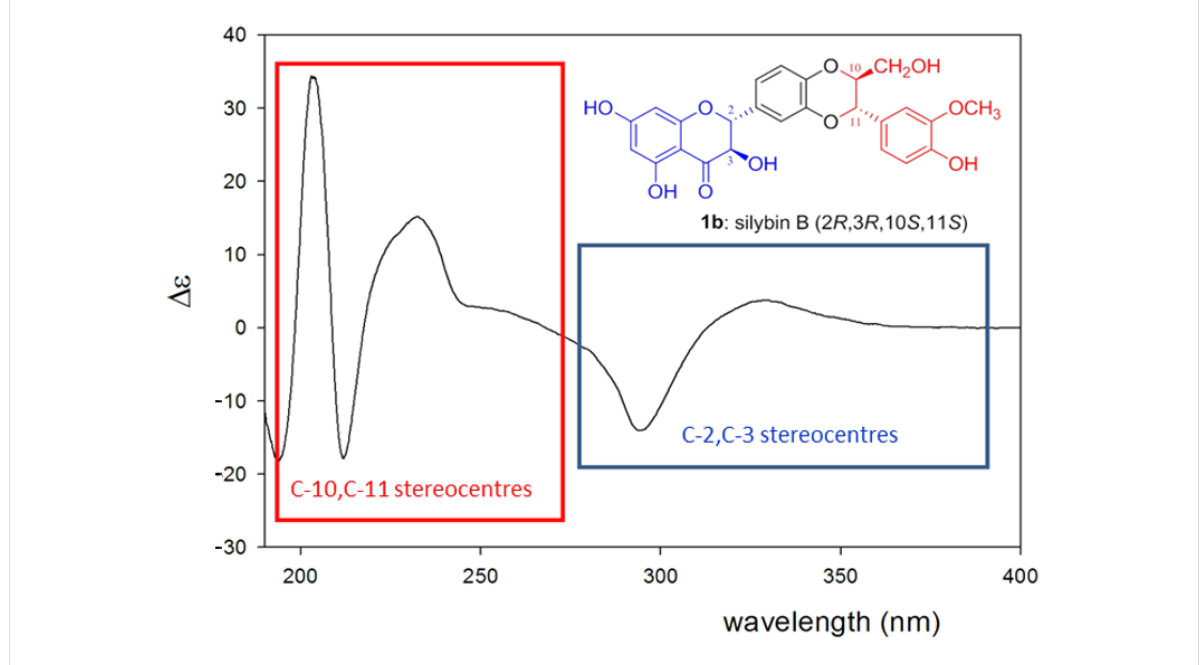
Figure 4: ECD spectrum of silybin B ( 1b ) and its separation (in a crude approximation) into two π -conjugated moieties (3-hydroxyflavonone with stereogenic centers C-2, C-3 (in blue) and 1,4-benzodioxane with C-10,C-11) (in red) according to [2].